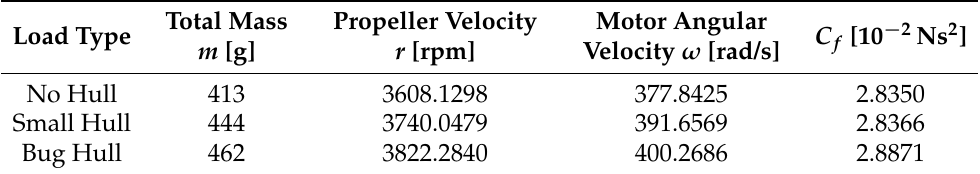
Table 2. Measured velocities and the C f value estimated with the Gaussian